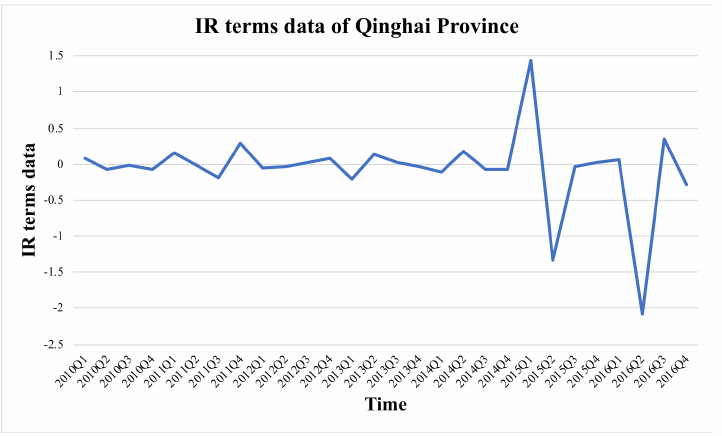
Figure 14. IR terms data of Qinghai Province.